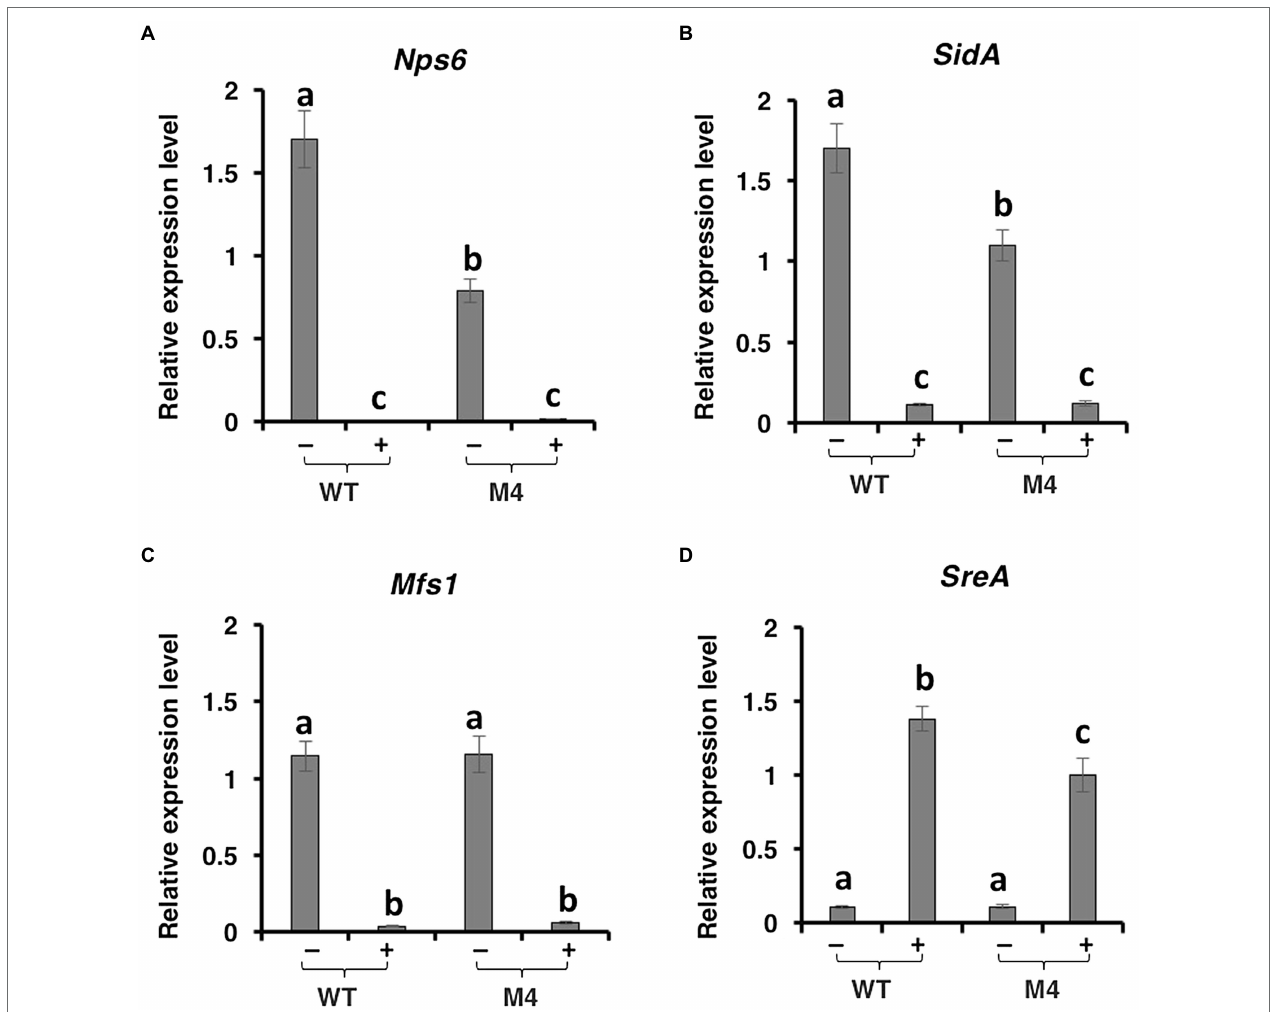
FIGURE 5 | Pex6 impacts the expression of genes involved in the biosynthesis, regulation, and transportation of siderophores in A. alternata . Quantitative real-time PCR analysis of the expression of: (A) a Nps6 gene encoding a nonribosomal peptide synthetase, (B) a SidA gene encoding an L-ornithine N5-oxygenase, (C) a Msf1 gene encoding a major facilitator superfamily (MSF), and (D) a SreA gene encoding a siderophore repressor in the wild-type (WT) and the ∆ pex6 M4 strains. The relative expression level from three independent reactions was calculated by a comparative CT method ( ΔΔ CT) in relation to the expression of fungal β -tubulin- coding